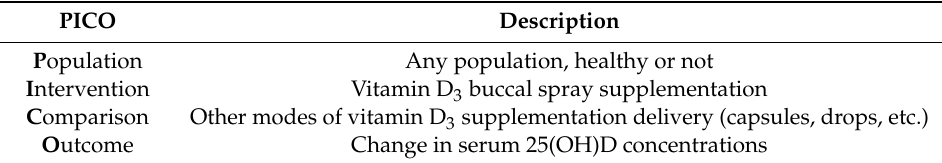
Table 1. PICO strategy for the search question.